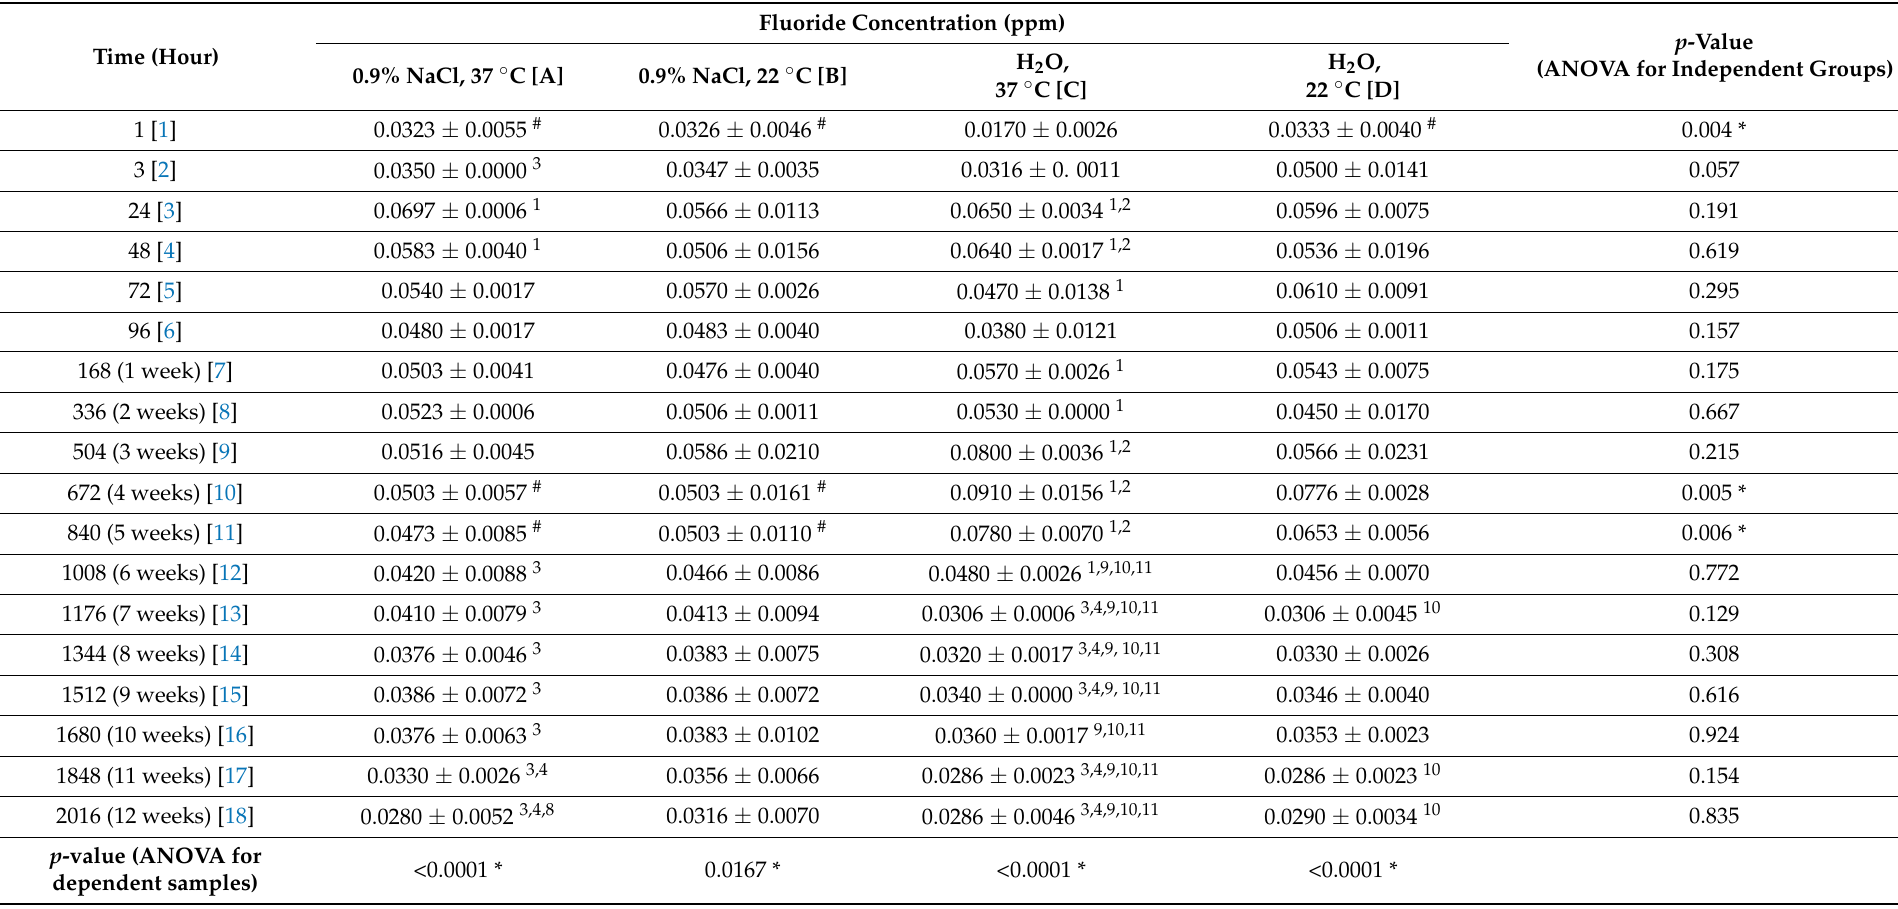
Table 1. The in vitro release of fluoride ions from nanofluorapatite into a saline solution or deionized water. Descriptive data were presented as the mean + standard deviation